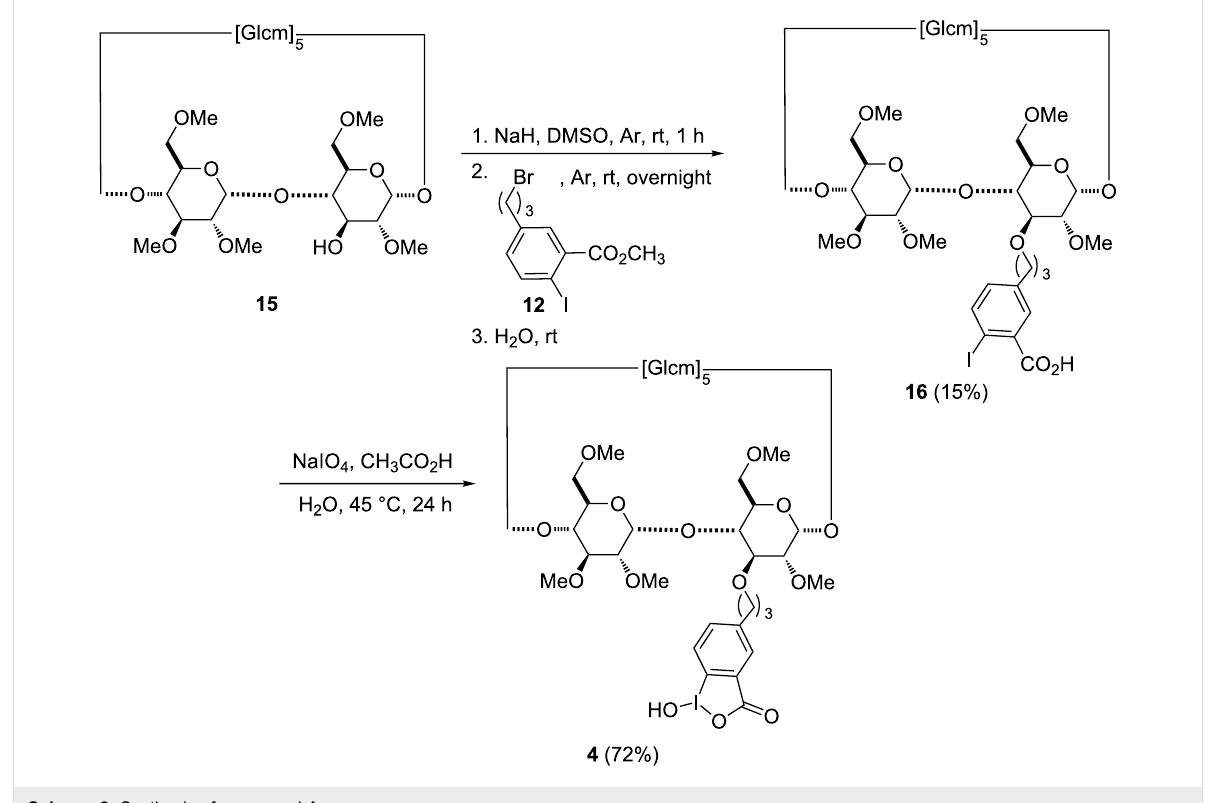
Scheme 2: Synthesis of compound 4